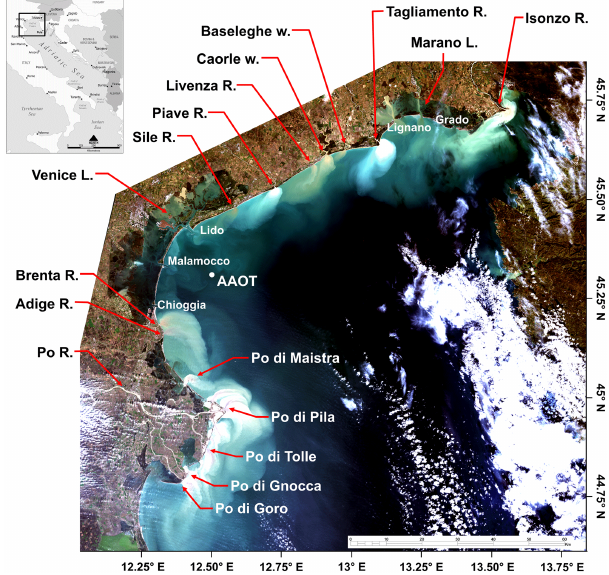
Figure 1. Study site with the location of rivers (R.), lagoons (L.), and wetlands (w.). Pseudo-true-colour Landsat 8 OLI imagery ac- quired on 19 November 2014. AAOT is the Acqua Alta Oceano- graphic